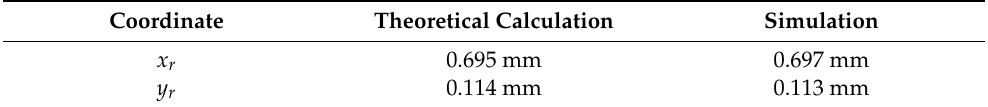
Table 4. Comparison of stagnation line locations.